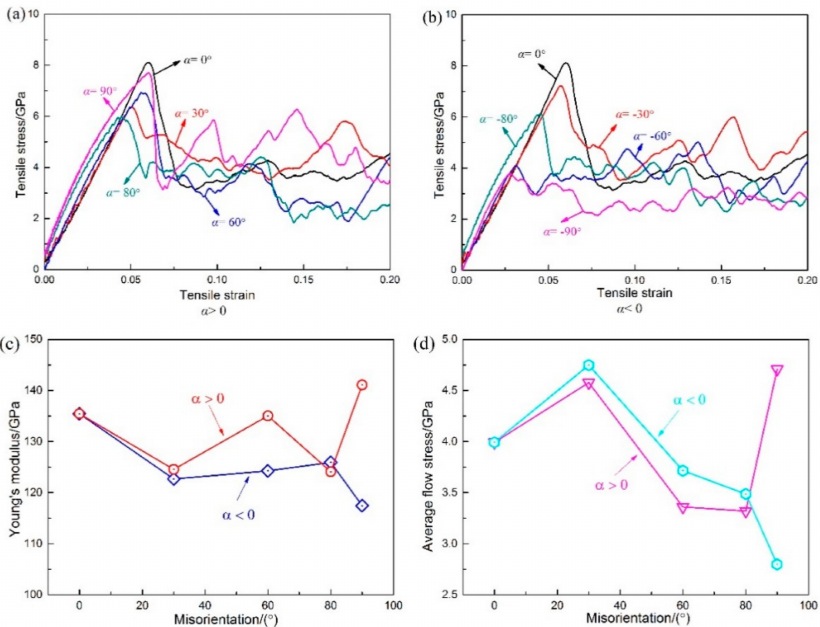
Figure 2. Stress–strain curves of models with λ = 88.66 Å: ( a ) α > 0, ( b ) α < 0; e ff ect of misorientation on Young’s modulus and mean flow stress of Ni / Ni 3 Al multilayers: ( c ) Young’s modulus, ( d ) mean flow